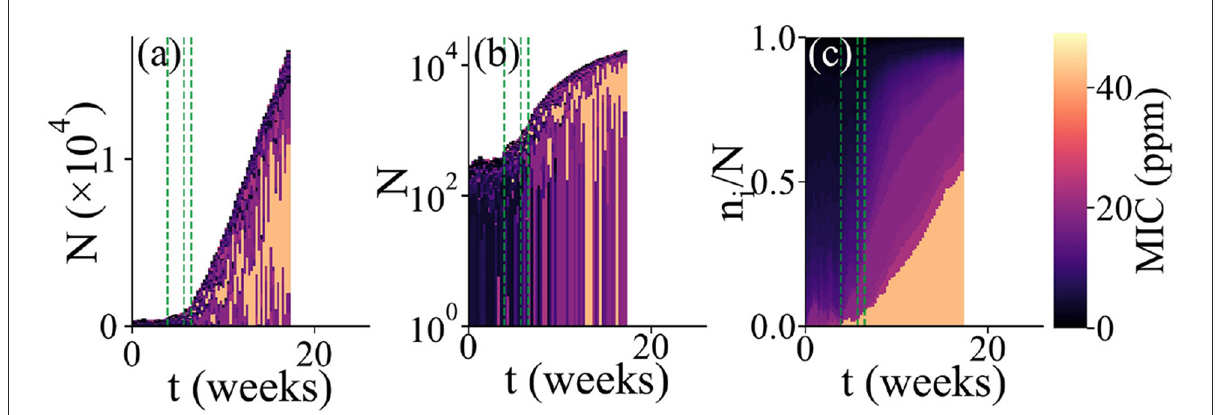
FIGURE2 Simulation of microbial colonization of an AF surface. An example of a simulation run in which a biofilm is established. The population composition vs. time t is represented in 3 different ways. In all cases, the colors represent the resistance levels (MIC, in ppm) of microbes within the population (see color scale). For each time point, a vertical bar shows the state of the population; these bars are stacked adjacent to each other to show dynamical changes. This run stopped when the biofilm reached the thickness limit of 40 microhabitats. The green dashed lines represent times at which new microhabitats were added to the system. For clarity, only the first 3 such events are shown. (a) Total population size and composition. Here, the bar height represents the total population size. The colors show the resistance levels within the population; here, individual bars for each microhabitat are stacked such that the lower part of each bar represents the region of the biofilm close to the surface while the upper part represents the region further from the surface. (b) Same plot as in (a) , but with a log scale on the vertical axis. (c) Relative population composition. Here, the colors represent the resistance levels present in the population, as fractions of the total